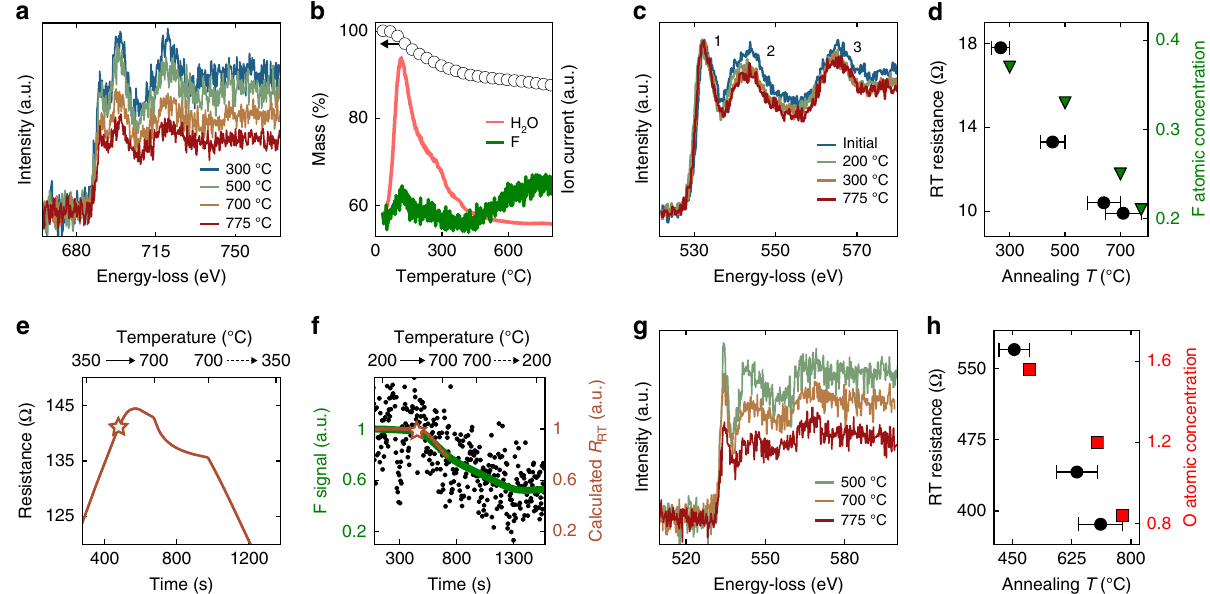
Fig. 3 Correlation of MXene surface termination and conductivity. a In situ EELS of the Ti 3 C 2 T x F K -edge showing the loss of – F with annealing. b TGA-MS of Ti 3 C 2 T x showing de-intercalation of H 2 O completing by ~400 °C and the onset of – F de-functionalization at ~400 °C. c In situ EELS of the Ti 3 C 2 T x O K - edge with annealing. The relative decrease in peaks 2 and 3 relative to peak 1 indicates the loss of intercalated H 2 O and the retention of = O. d Comparison of the post-anneal RT resistance of Ti 3 C 2 T x (black circles) and – F concentration (green triangles) given in units of x based on the chemical formula Ti 3 C 2 O 0.5 F x . e , f show the time-resolved resistance and F K -edge intensity, respectively, of Ti 3 CNT x during in situ annealing. The solid (dashed) arrows represent heating (cooling). For the time axis, t = 0 s corresponds to the beginning of annealing at RT. The stars mark 500 °C, the maximum temperature of prior annealing. The green line in f is a Gaussian smooth of the EELS data (black circles). The dark orange line in f is the calculated RT resistance, determined using the measured value of d R /d T upon heating. Because d R /d T changes with annealing, this calculation is only valid up to ~700 °C. To highlight the correlation between the – F concentration and the calculated RT resistance, both quantities were normalized by their initial value. g In situ EELS spectra of the O K -edge of Mo 2 TiC 2 T x . h Comparison of the post-anneal RT resistance (black circles) with the concentration of = O (red squares), given in units of x based on the chemical formula Mo 2 TiC 2 O x . For a , c , and g , EELS spectra were acquired at RT after annealing, and the edge intensities were normalized to the Ti L -edge intensity. In d and h , the change in elemental concentration was determined with in situ EELS. The temperature offset between elemental concentration data and resistance measurements in d and h are due to thermal gradients within the nanochip (Supplementary Figure 10). The range of these thermal gradients are represented by the horizontal error bars in the RT resistance